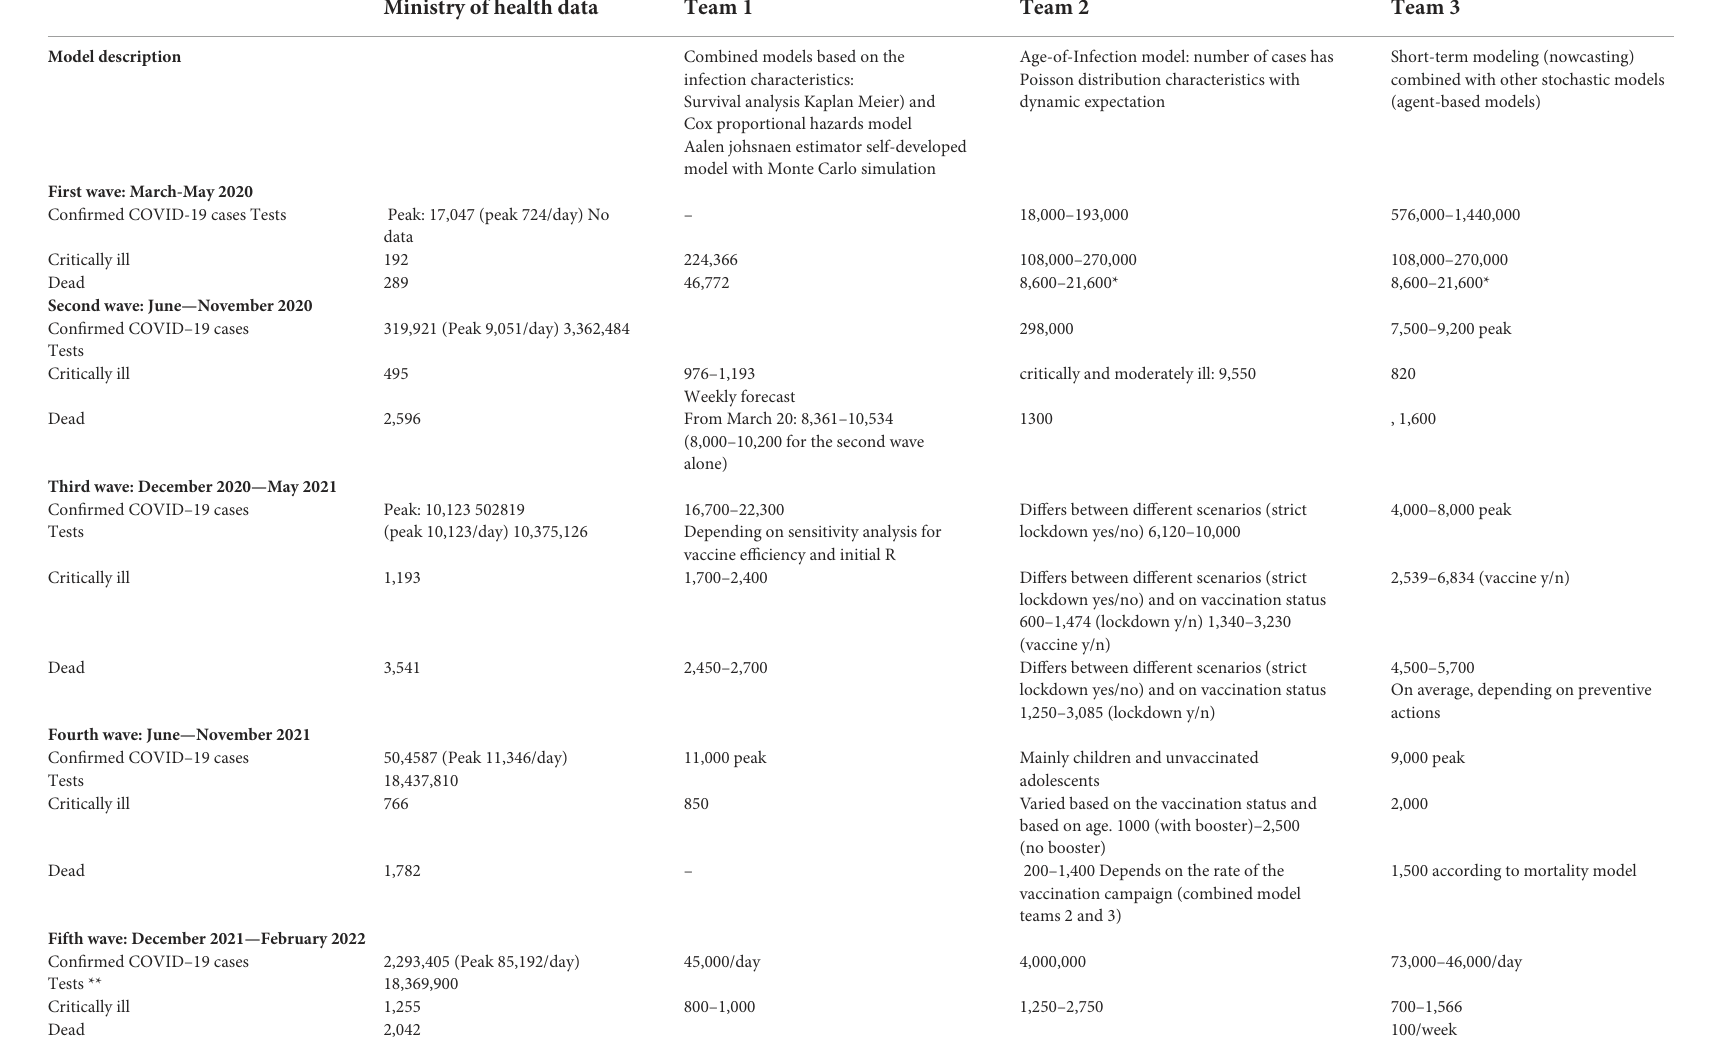
* Teams2and3workedtogetheratthebeginningofthepandemic,joiningforcesinordertoprovidescientificassumptionstopolicymakers.Asaresult,thesamepredictionwasprovidedbybothteams.Lateron,astheseteamsseparated,differencesin forecastswereobserved. **